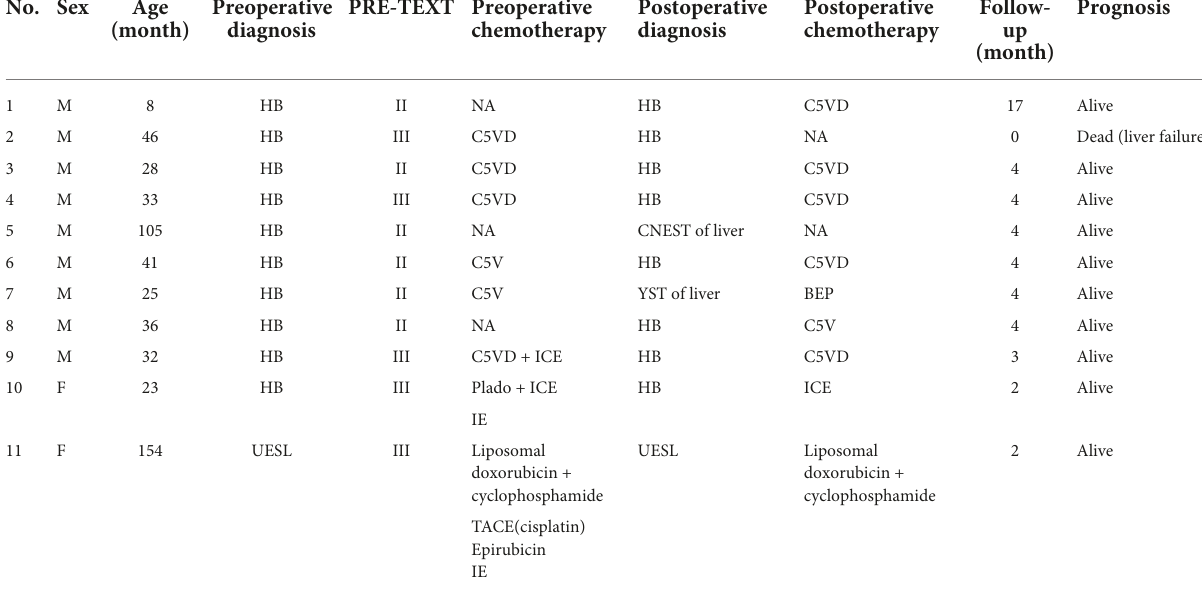
TABLE 1 Clinical characteristics of the 11 cases with liver cancer.